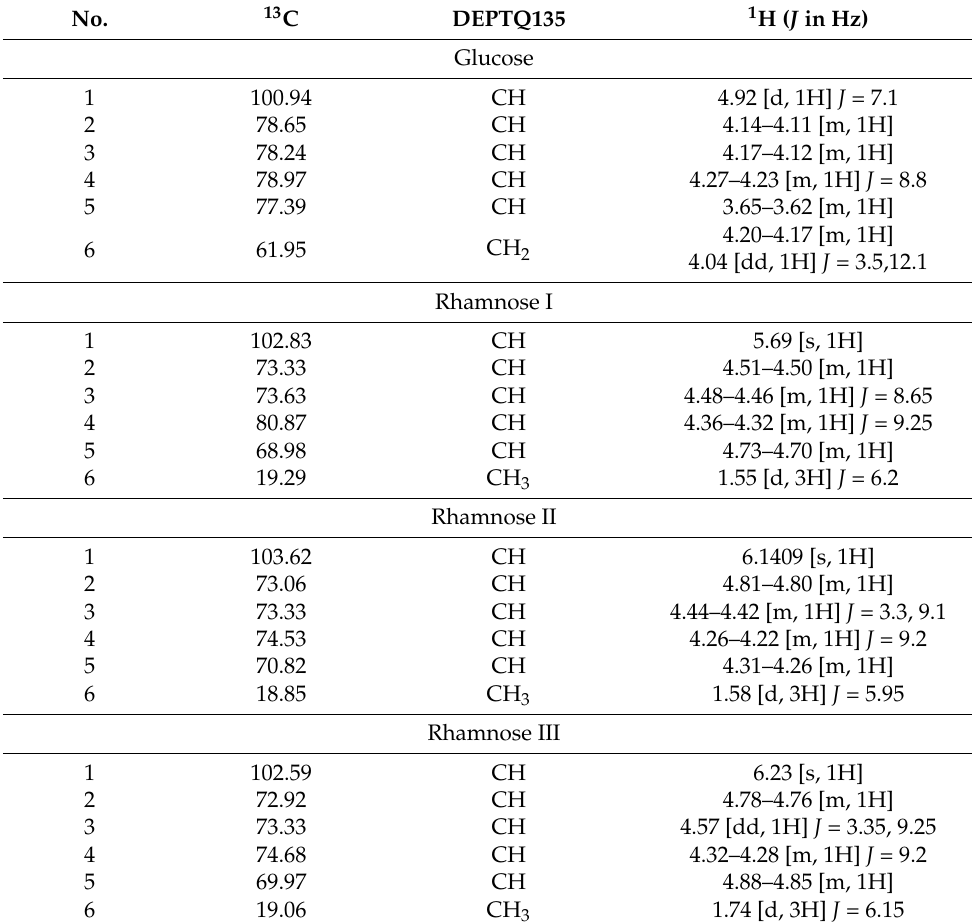
Table 3. 1H-NMR and 13C-NMR spectroscopic data [500 and 125 MHz, Pyridine d5, 50 ◦ C] of the sugar moieties of the pennogenin